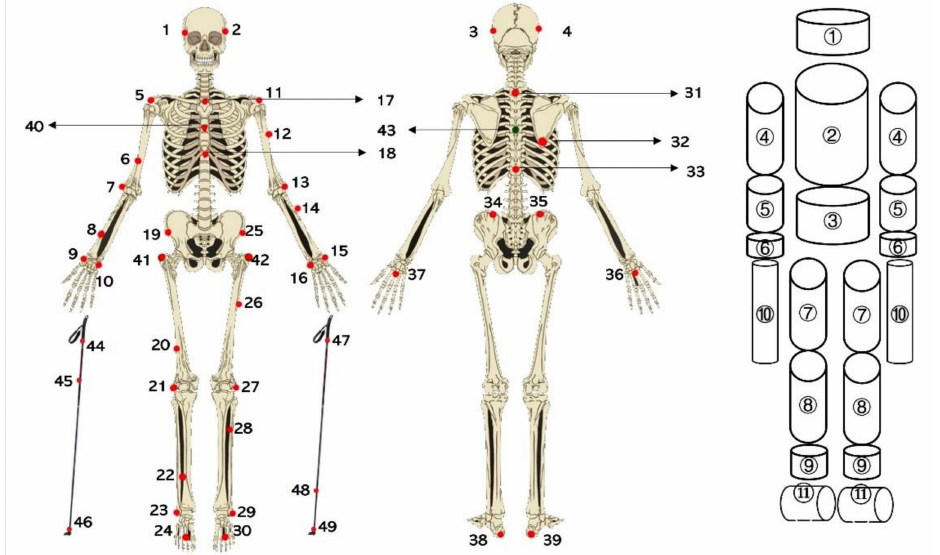
Figure 2. Marker placement on the subject and geometric model for segments in the XC model. The numbers 1–49 represent the placement of reflective markers on subjects and poles. The displacement of reflective markers on roller skis is shown in Figure 3. The numbers 1–39 are the markers used in the plug-in-gait (PIG) model. 1–43 are the markers used in the XC model [6] on one subject. The numbers 44–49 are the markers on the poles. 1 (cid:13) –11 (cid:13) represent the head, thorax, abdomen and pelvis, upper arm, forearm, hand, thigh, shank, foot, pole, and roller ski, respectively.